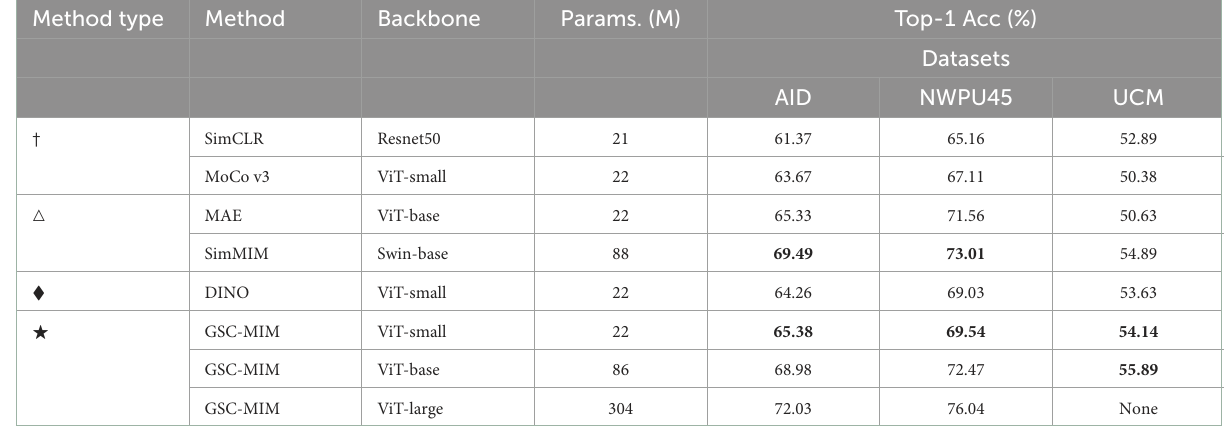
TABLE 2 Experimental results comparison with SOTA methods.